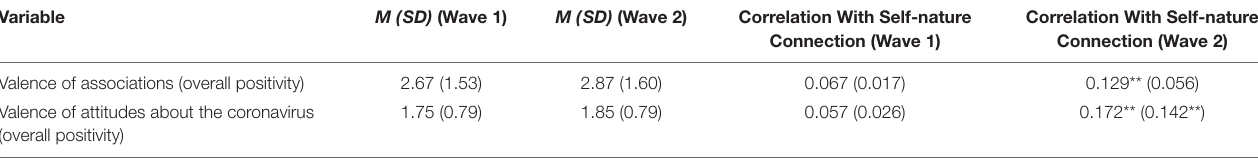
TABLE 3 | Higher-order beliefs about the pandemic and self-nature connection: Descriptive statistics and correlations. Variable M (SD) (Wave 1) M (SD) (Wave 2) Correlation With Self-nature Coronavirus has come to tell us we are not the kings of the world.